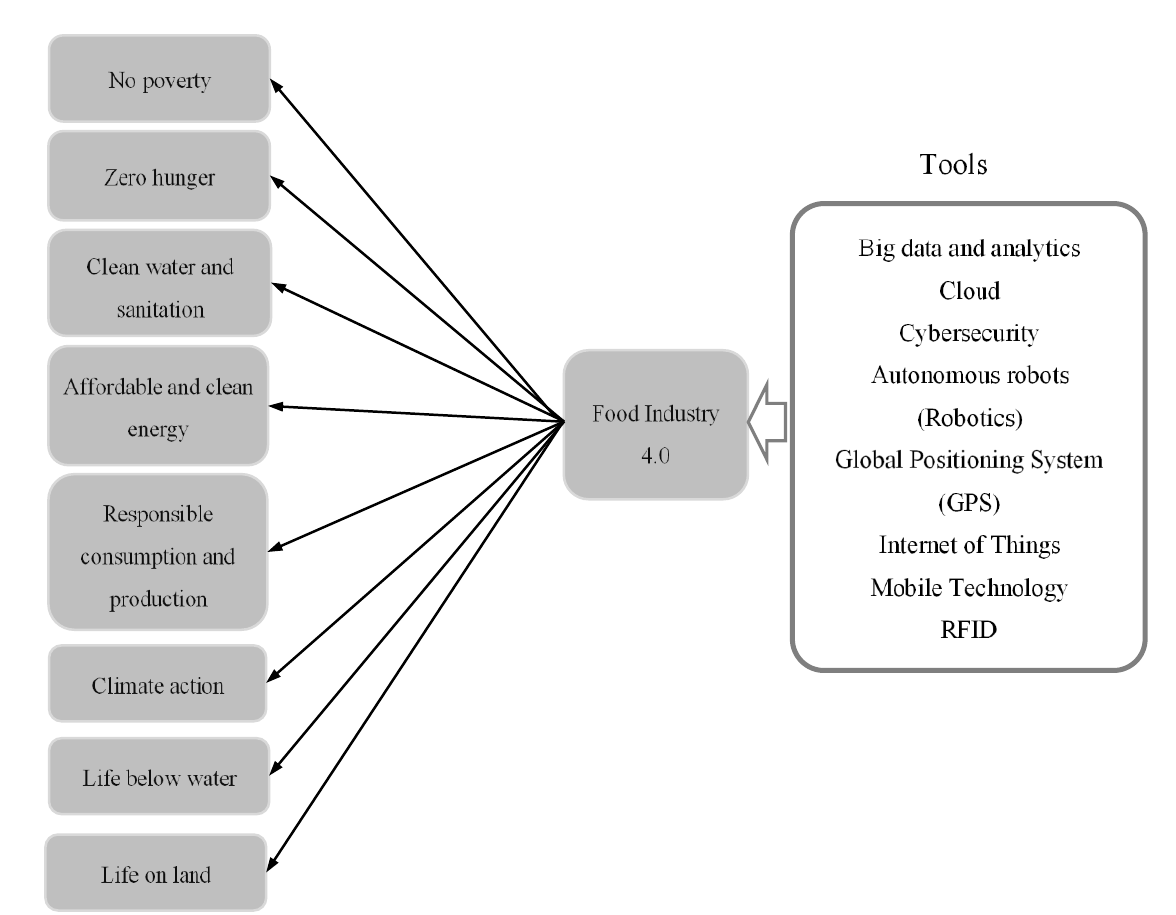
Figure 4. SDGs and Food Industry 4.0.